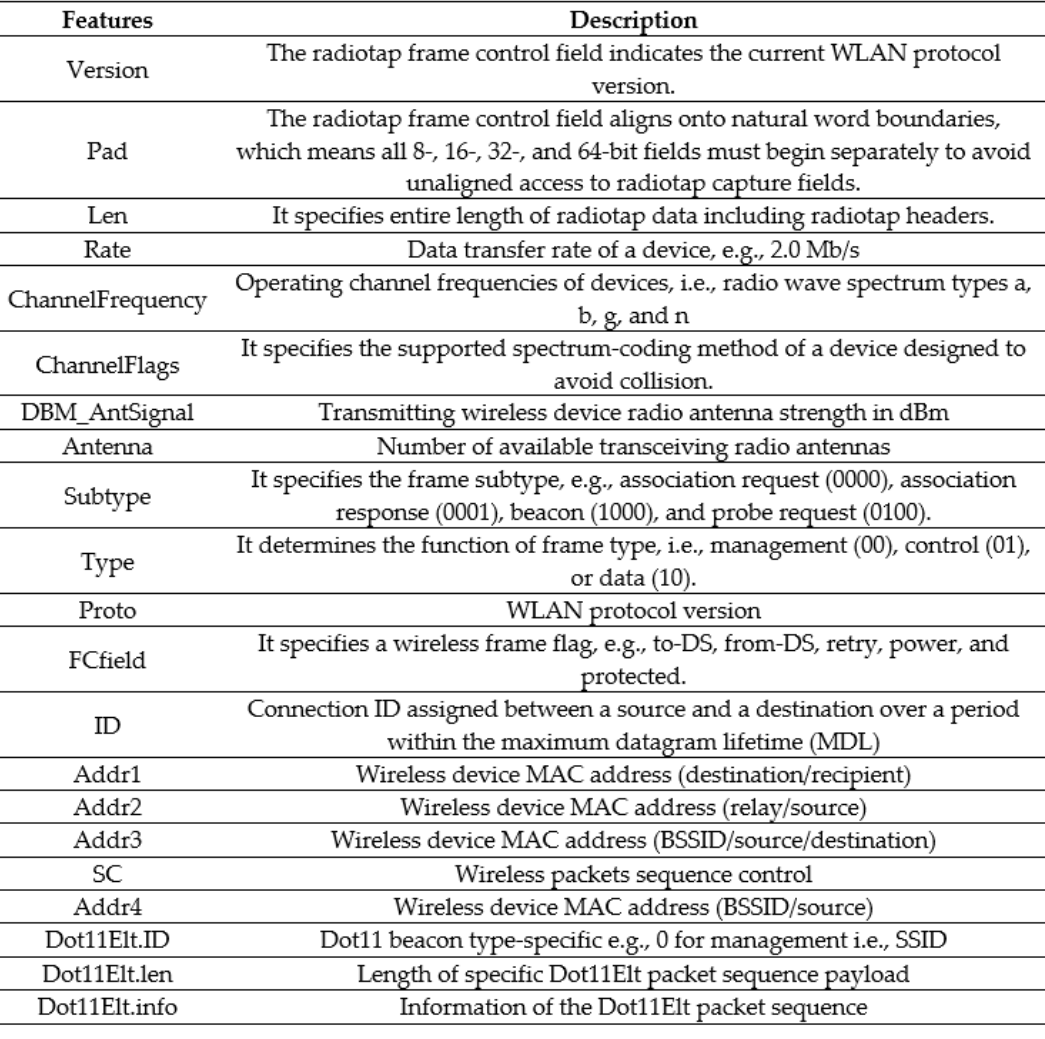
Figure 8. IoT wireless features.